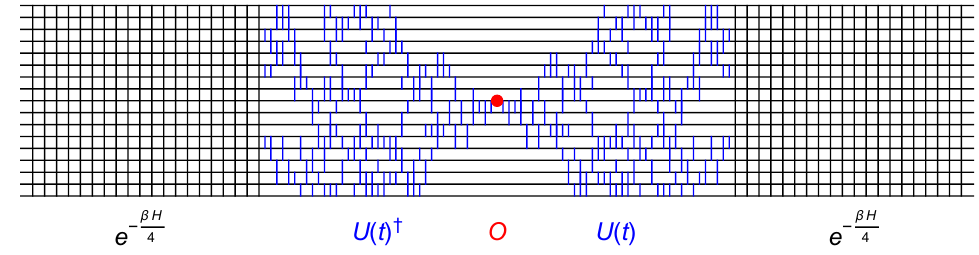
Figure 1 . A cartoon of a Heisenberg operator inserted at the half of the thermal circle. Some gates of U ( t ) † and U ( t ) on the unaffected channels have been canceled with each other, due to the switchback